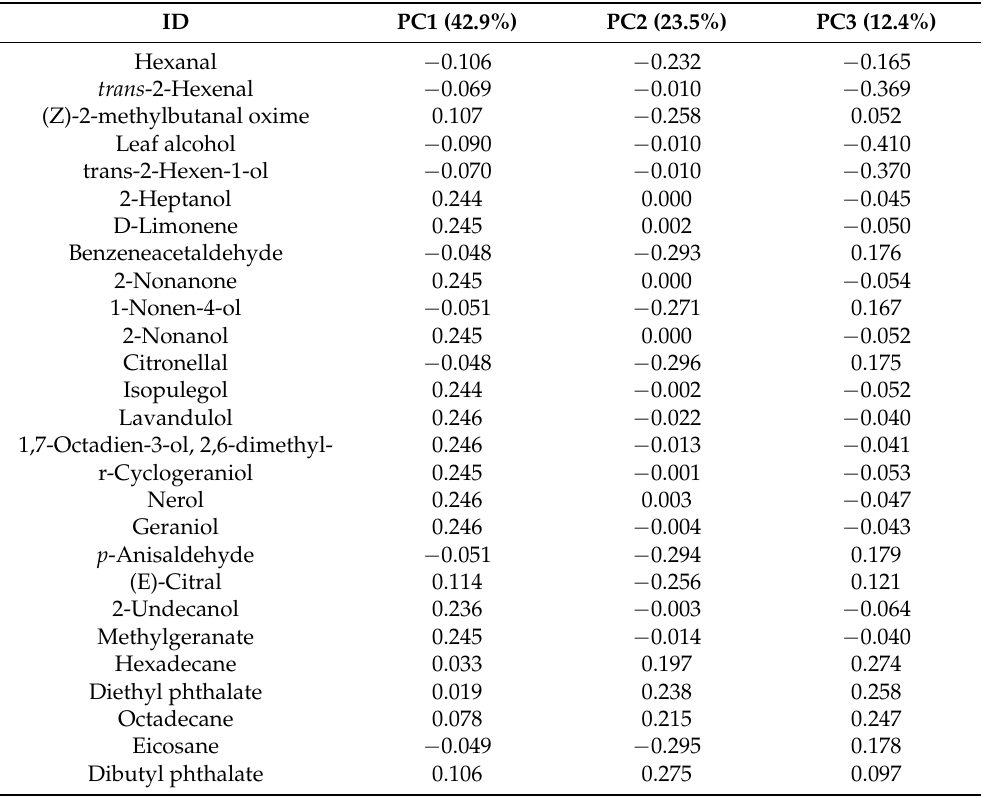
Table 5. Principal component loading for the three principal